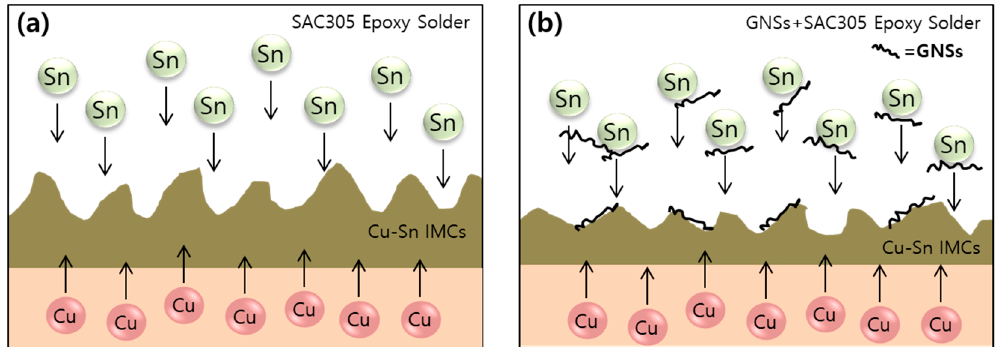
Figure 8. Schematic diagram of IMC growth in ( a ) SAC305 epoxy solder joints and ( b ) GNS/SAC305 epoxy solder joints.